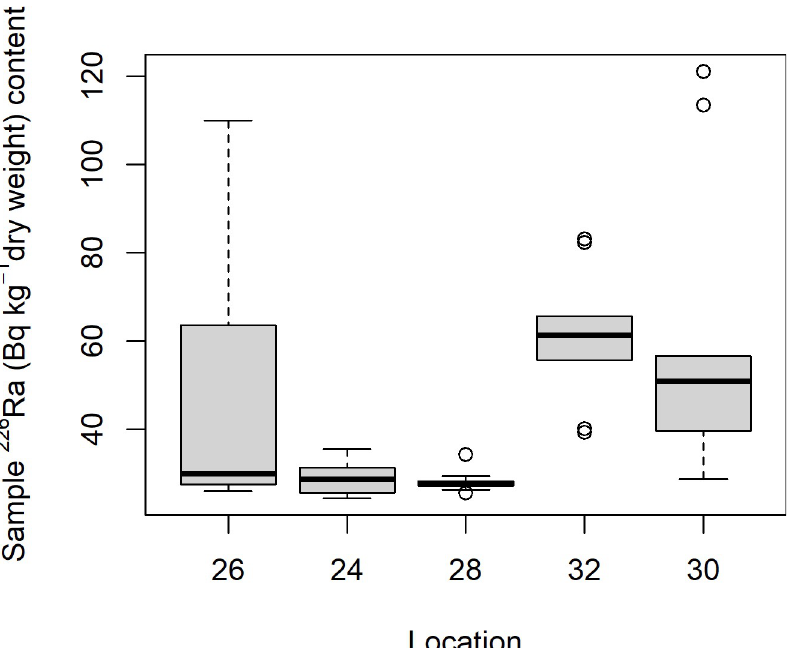
Fig 8. Boxplot of 226 Ra (Bq kg -1 d.w.) of soil samples among localities within Mining hill.